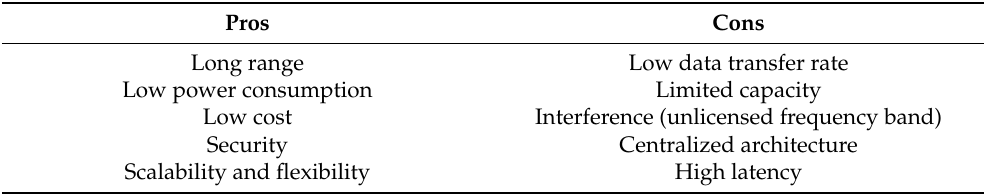
Table 1. The pros and cons of of implementing LoRa and LoRaWAN